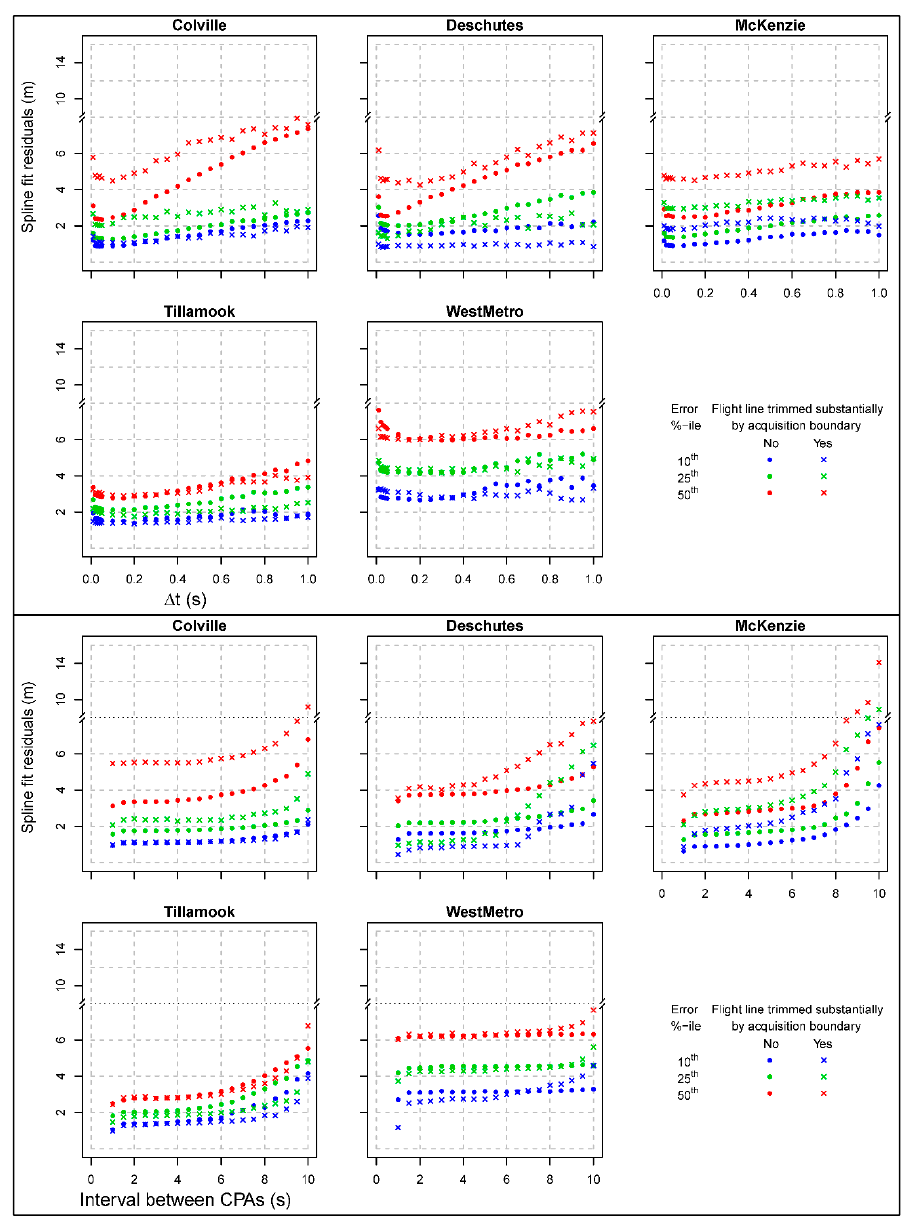
Figure A1. Distribution of residuals in splines fit to flight line-specific CPA sets across study areas as function of time block duration (top) and time intervals between CPAs used in the fitting (bottom). Dots/Xs pertain to CPA sets from scan swaths free of/affected by substantial trimming with acquisition boundaries respectfully. Note scale discontinuities along the Y axes.